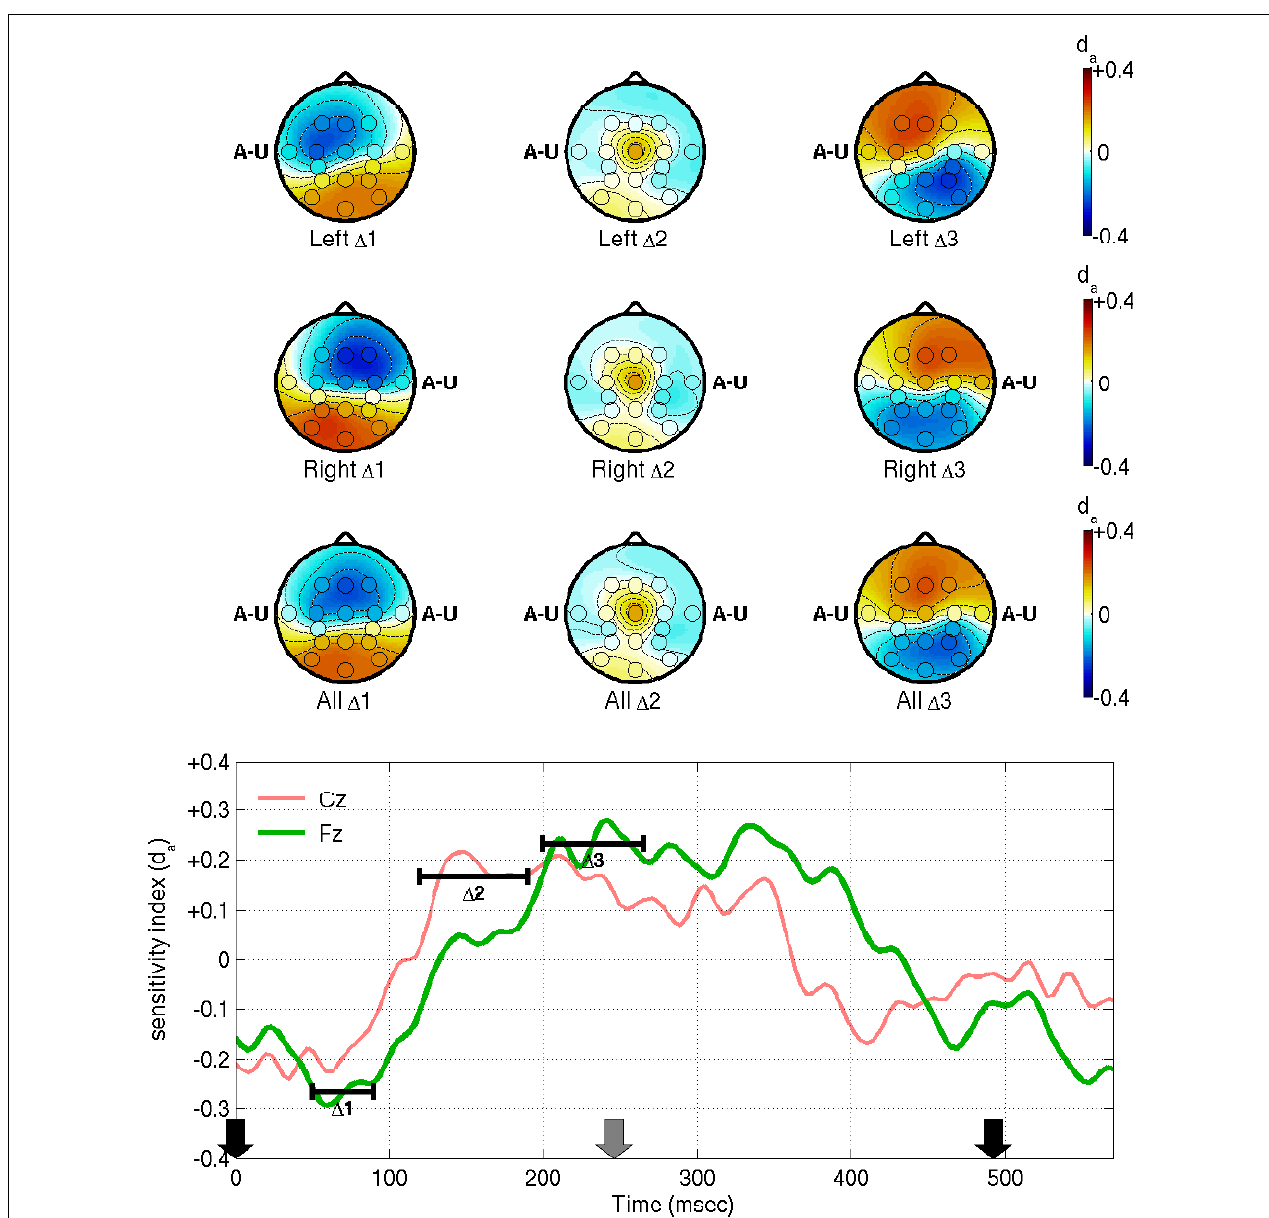
the arrows (black and gray arrows denote stimuli from opposing streams).The ranges marked (cid:49) 1, (cid:49) 2, and (cid:49) 3 were chosen based on these traces, at 50–90, 120–190, and 200–265ms, respectively. Scalp maps show d a averaged within each of these ranges, for left-ear stimuli at time 0 (first row), right-ear stimuli at time 0 (second row), or for all stimuli irrespective of laterality (third row). The letters A–U appear at the ear positions of the scalp maps, as a reminder of the ear stimulated at time 0 and of the fact that, unlike those of Figure 3 , the topographies represent a contrast between attended and unattended